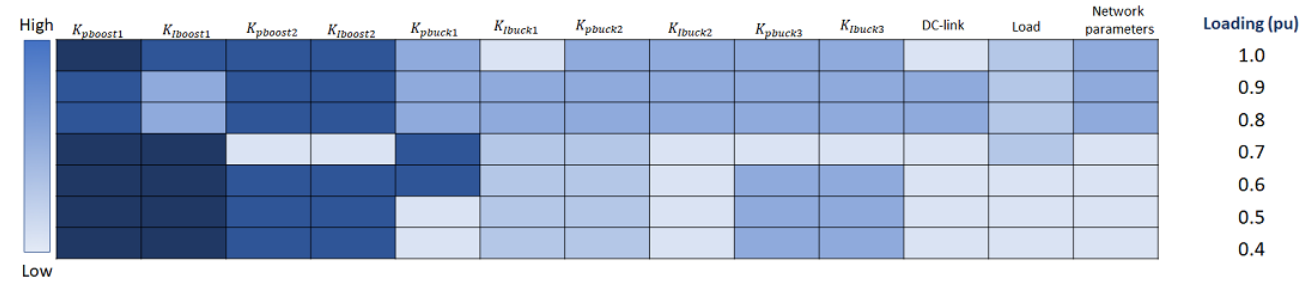
Figure 12. Heatmap of ranking critical parameter for oscillatory stability.